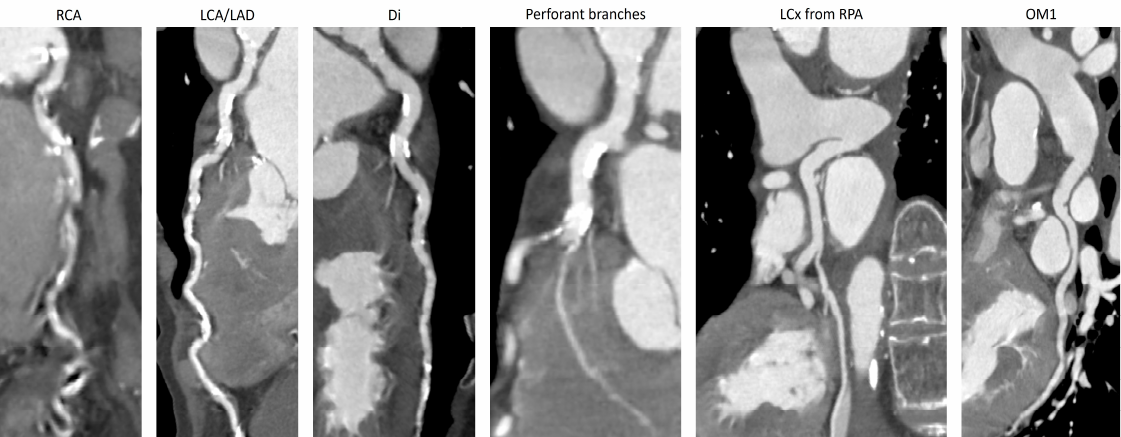
Figure 1. Curved reformat of the coronary arteries from their ostia. There were extensive calcification on the branches, starting from the systemic circulation (RCA, LCA/LAD, and diagonals), and only trivial calcification spots in the left circumflex coronary artery and in the obtuse marginal branch. The coronary arteries are enlarged, with perforant branches from the LAD reaching 2 mm in diameter. RCA—right coronary artery; LCA—left coronary artery; LAD—left anterior descending coronary artery; Di—diagonal branch; LCx—left circumflex coronary artery; OM1—first obtuse marginal.